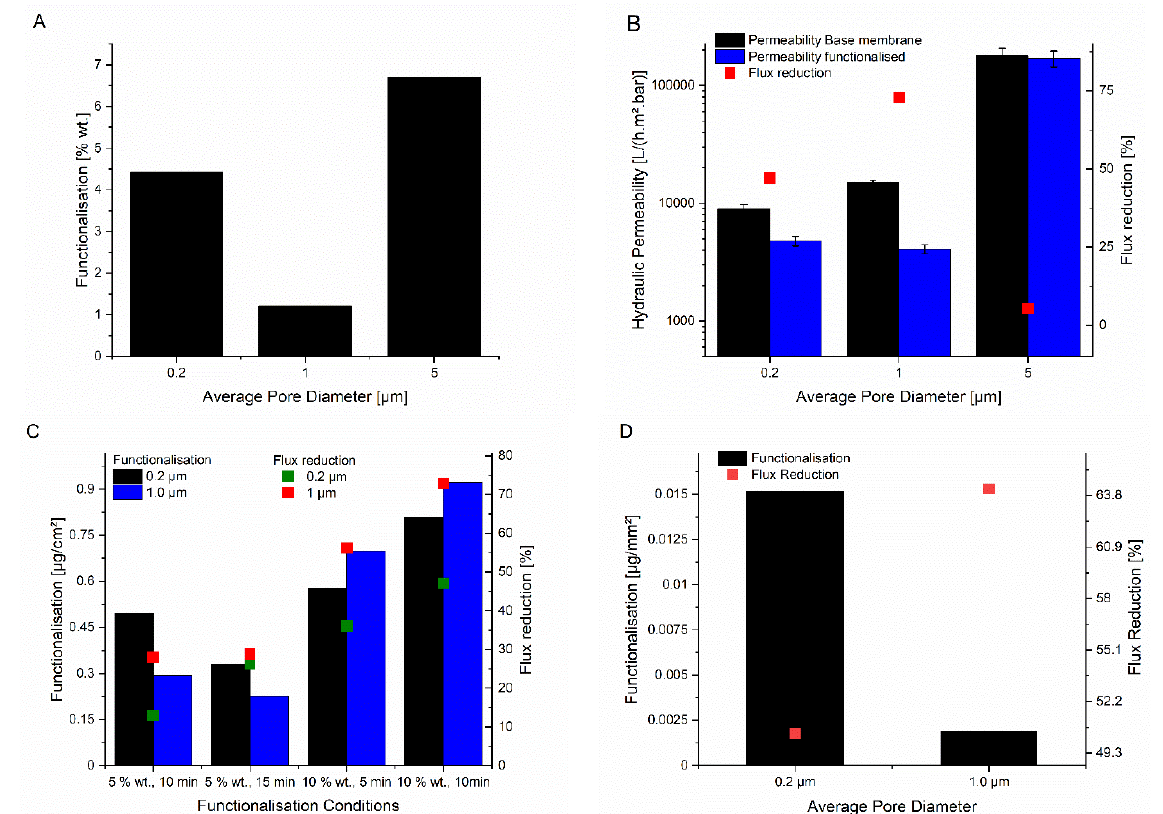
Figure 1. Surface functionalisation of track-etched membranes: ( A ) Extent of PAGA-functionalisation depending on pore size; ( B ) Influence of PAGA-functionalisation on membrane permeability; ( C ) Degree of functionalization normalized to specific surface area of the respective base membrane and permeability after functionalisation with PAGA; ( D ) Specific surface area-normalized degree of functionalization and permeability after functionalisation with PNADha.